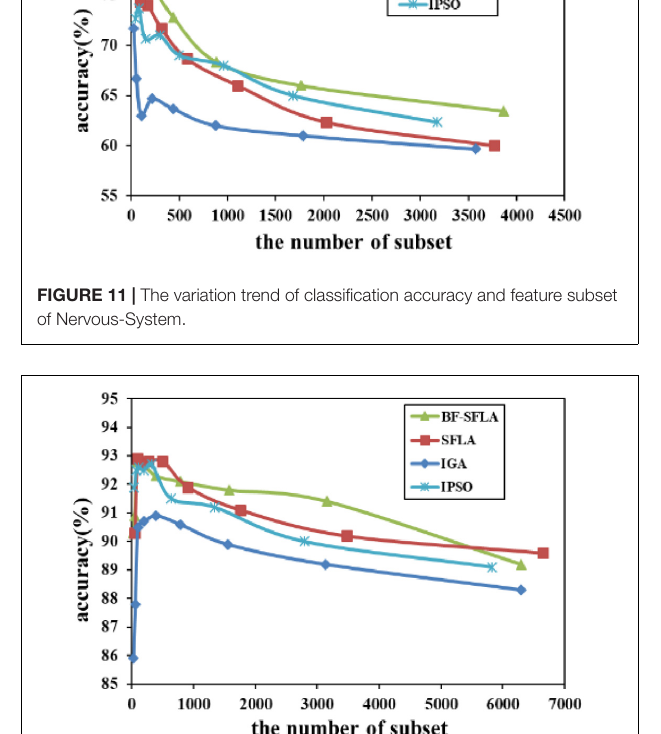
FIGURE 12 | The variation trend of classification accuracy and feature subset of lungcancer-harvard1.